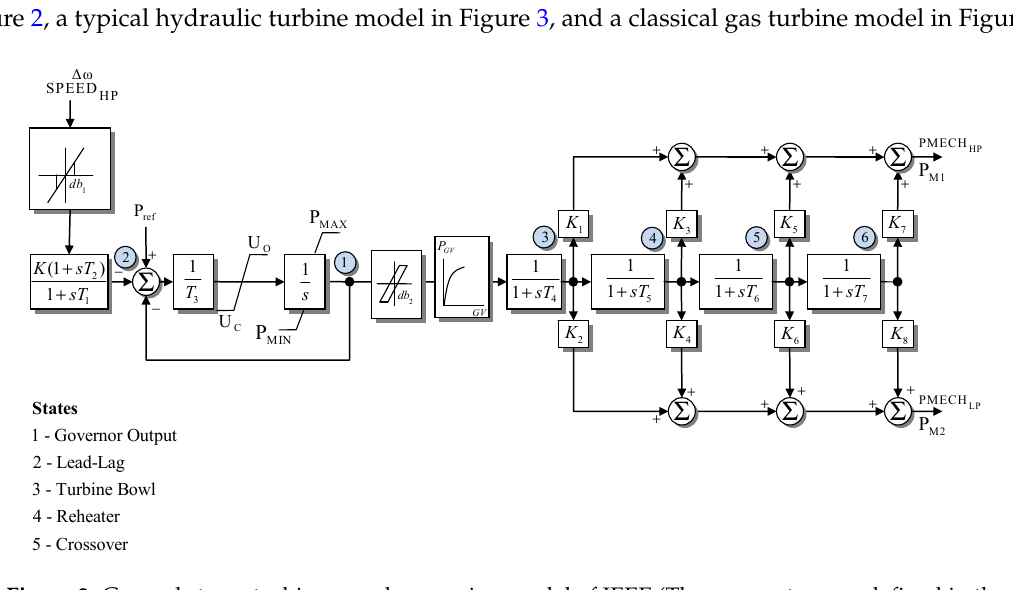
Figure 2. General steam turbine speed governing model of IEEE. (The parameters are defined in the literature [27])